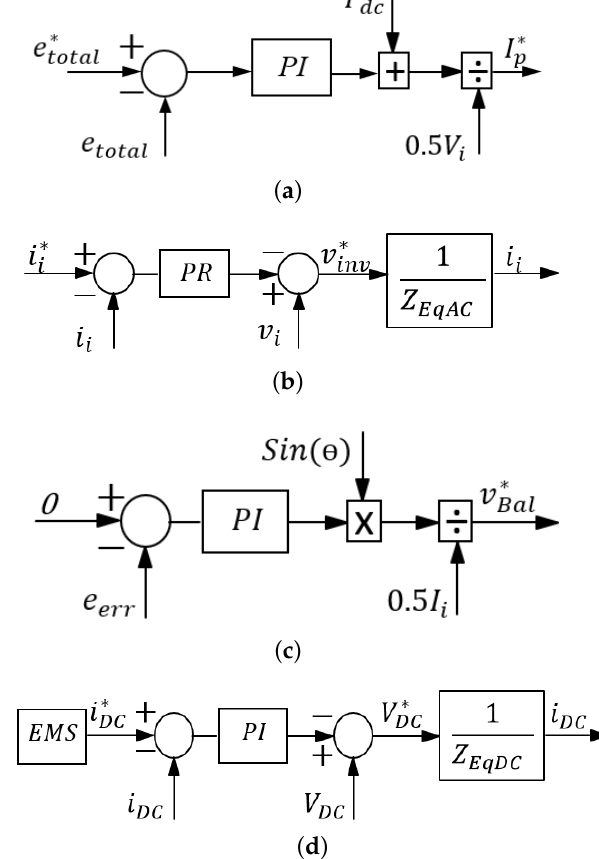
Figure 4. Total energy controller ( a ), AC controller ( b ), arm balancing controller ( c ), DC controller ( d